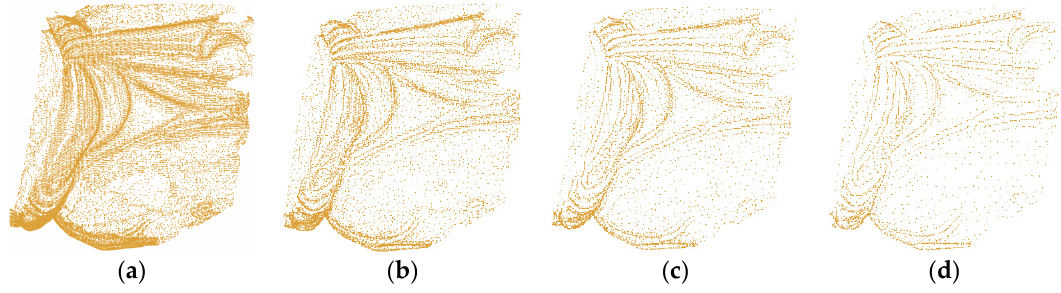
Figure 7. Four levels of points of a small point cloud: ( a ) δ = 3.0, ( b ) δ = 4.0; ( c ) δ = 5.0, and ( d ) δ = 6.0.